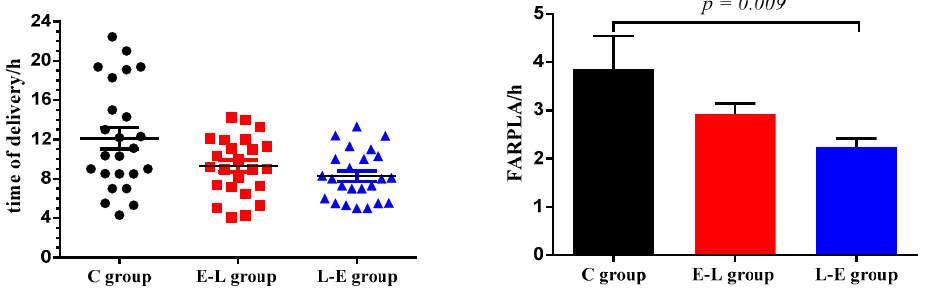
Figure 1. Duration of farrowing and placenta expulsion (FARPLA) of sows, FARPLA is defined as the time interval between the birth of the first piglet and the expulsion of the last placenta. n = 25.